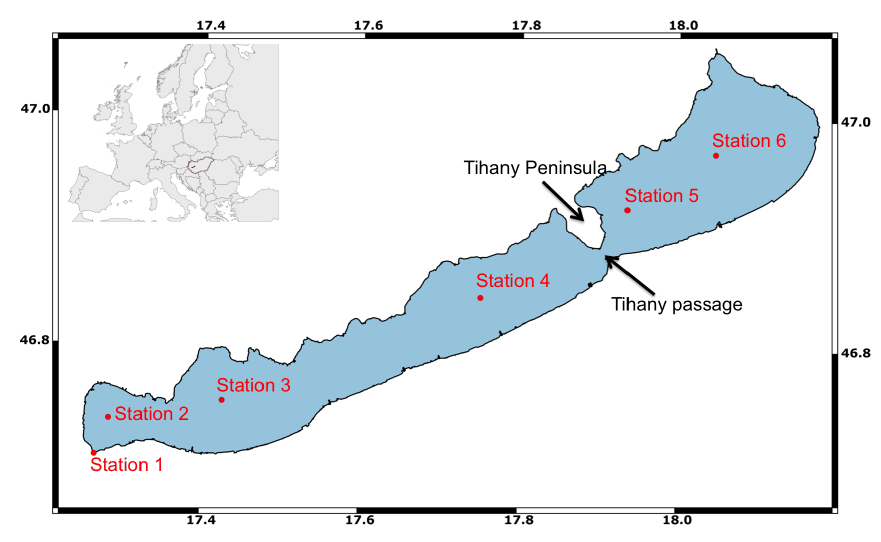
Figure 1. Location of Lake Balaton and the investigated stations. Table 1. Geographical information of the investigated stations in Lake